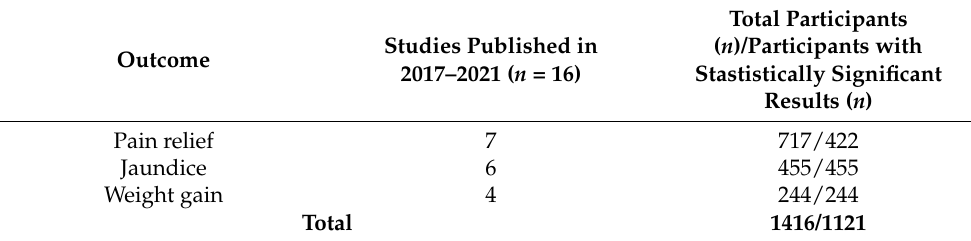
Table 1. Effect of infant massage on pain relief, jaundice and weight gain.